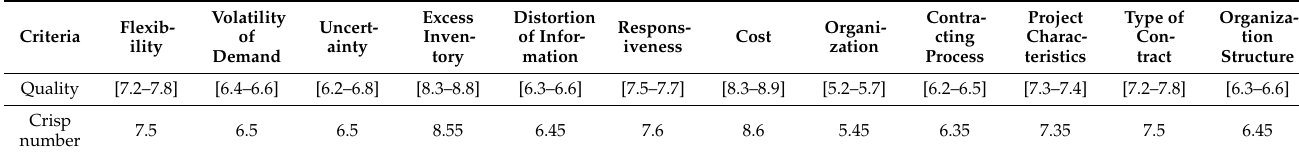
Table 6. Best criteria DMs’ preferences.